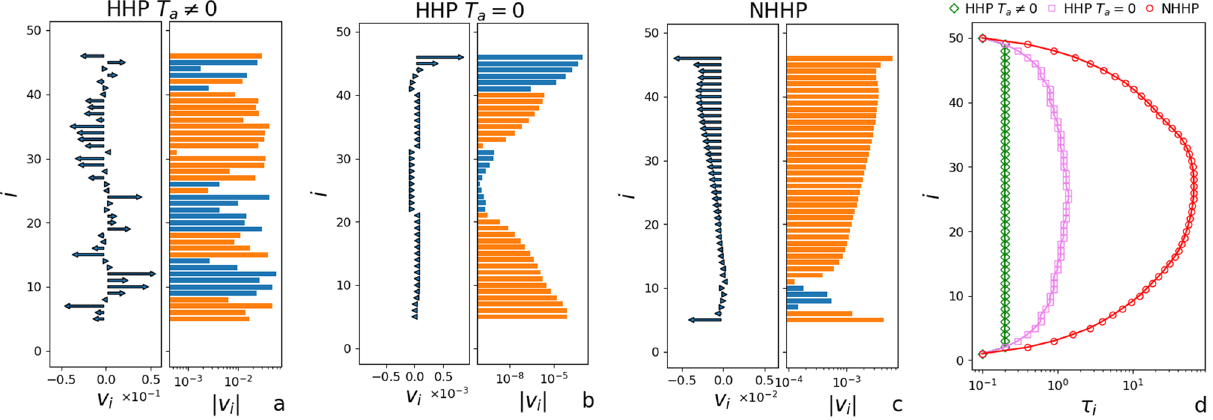
Figure 1. ( a – c ) Snapshots of the velocity field in the stationary state of the two phases. We exclude the first five (really hot) sites near the boundaries to have a more clear view of the field. Each panel shows the vectors in linear scale and the moduli in log scale in order to better appreciate the phenomenology of the system. Orange and blue bars discriminate the two directions. We note that a great cluster of particles with same direction and similar modulus is found in the NHHP only, signaling that in terms of correlations the key parameter 0.4 . The is γ a rather than T a . ( d ) Autocorrelation times for each site defined as the time τ i for which Ŵ i (τ i ) = lim / ( t ) v i ( t ) v i ( t t ′ ) v 2 autocorrelation function is defined as Ŵ( t ′ ) where the brackets refer to a t i = + � � � →∞ � time average on the stationary state. We note that in the NHHP the dynamics is far slower than in the HHP 0 . The snapshots are obtained by numerical integration of Eq. (1) with L 50 , γ 5 , γ 10 , also when T a b = = = = 0.002 , T 3, 0 10 8 /γ and with a temporal step dt 0.05 /γ 0.002, 0 γ a T L , T 1 after a time t M a = { = = = { } = = }